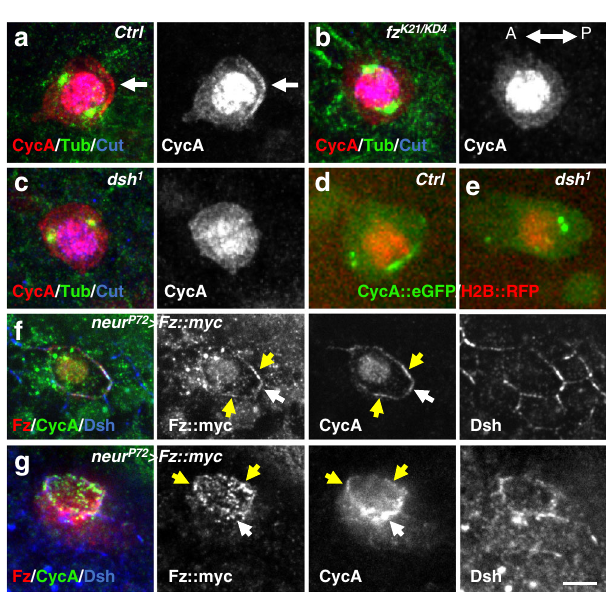
Fig. 3 CycA is recruited by the posterior PCP complex. CycA localization in control ( a , d ), fz mutant (B) and dsh mutant ( c , e ). CycA immunoreactivity (red) in prophase pI cells identi fi ed by Cut (blue) immunostaining in control ( a ), fz K21/KD4 ( b ) and dsh 1 (c) pupae 17 h APF. All pI cells are at the same stage as revealed by the γ − tubulin immunostaining (green). Note that the apical-posterior enrichment of CycA (arrow in control, a ) is not observed in fz K21/KD4 ( b ) or dsh 1 ( c ). ( d , e ) in vivo dynamics of CycA::eGFP (green) in control ( d ) and dsh 1 ( e ) pupae expressing H2B::RFP (red) under the control of neur to identify pI cells. ( f , g ) Cortical CycA localization after fz overexpression. CycA (green), Fz (red) and Dsh (blue) immunostaining in pI cell 17 h APF expressing a myc- tagged-Fz form. White arrow points to the apical-posterior CycA crescent whereas yellow arrows indicate a spreading of the cortical recruitment of CycA. n = 20, 14, 10, 20, 16, 8 and 2 in a , b , c , d , e , f and g , respectively. Anterior is to the left. Scale bar, 5 μ